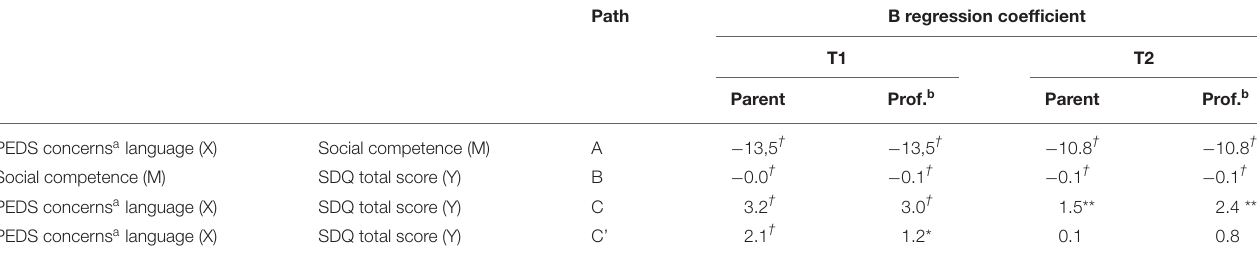
TABLE 8 | Mediating effect of social competence on the association of PEDS concerns about language development with SDQ total score at T1 and